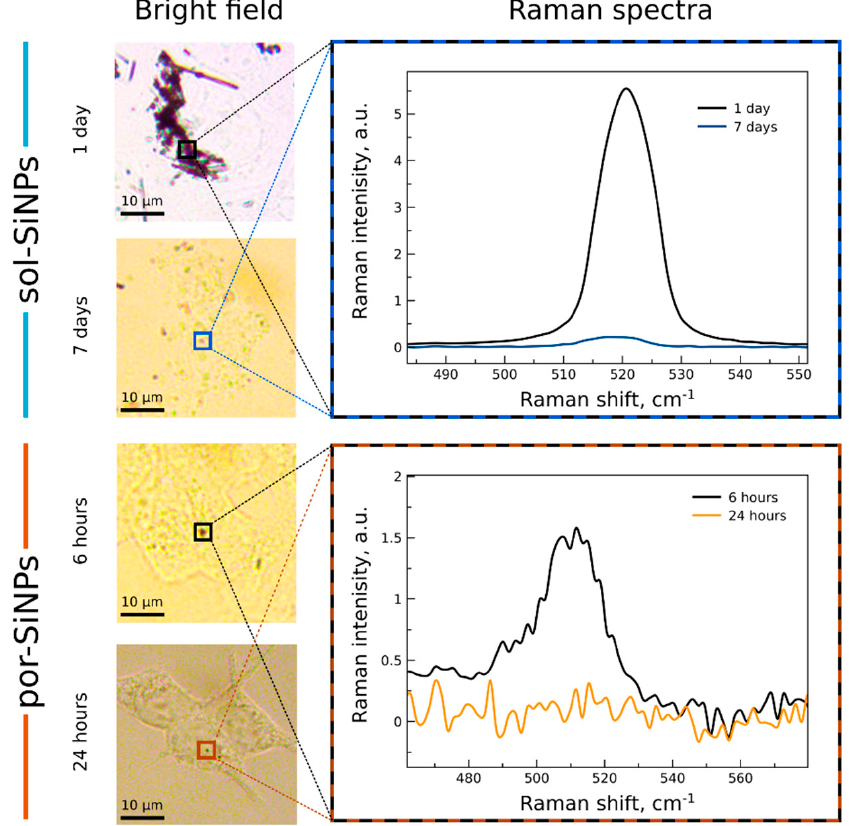
Figure 5. Widefield imaging and Raman spectra of SiNPs inside human cells (MCF7). Left side: widefield images of sol-SiNPs after 1 and 7 days of incubation and por-SiNPs after 6 and 24 h of incubation. Right side: corresponding Raman spectra of squared SiNPs.